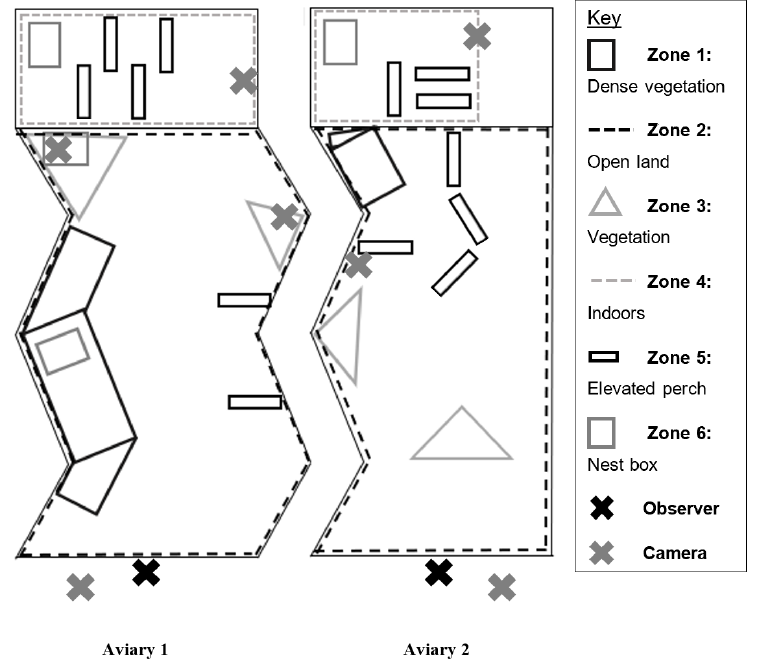
Figure 1. Enclosure layout for Aviary 1 ( left ) and Aviary 2 ( right ) with habitat zones and observer and camera positions highlighted in the key. Table 2. L. edwardsi ethogram. Adapted from [28,29]. Behavior Description